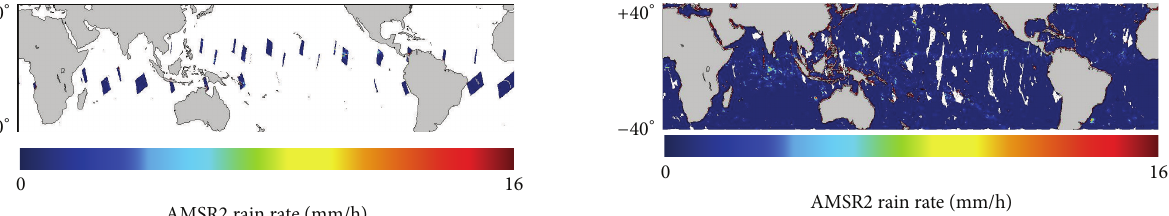
Figure 4: AMSR2 rain rates (mm/h), retrieved with the new algorithm, collocated within 10-minute time difference with RSS TRMM Microwave Imager rain rates. 25 August 2012.